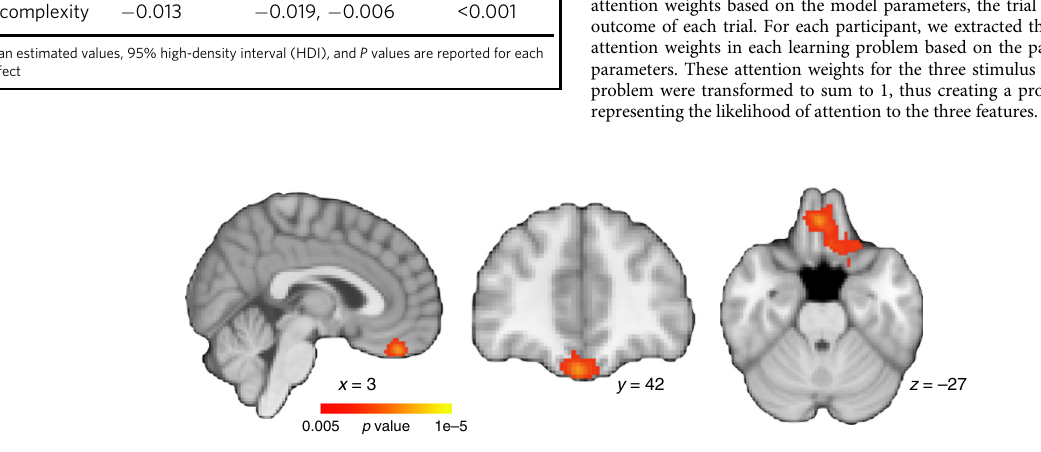
Fig. 5 A whole-brain voxel-wise linear mixed effects regression restricted to low and medium complexity problems ( N = 23). Similar to the main results in Fig. 2b, a cluster in vmPFC showed a signi fi cant interaction between learning block and problem